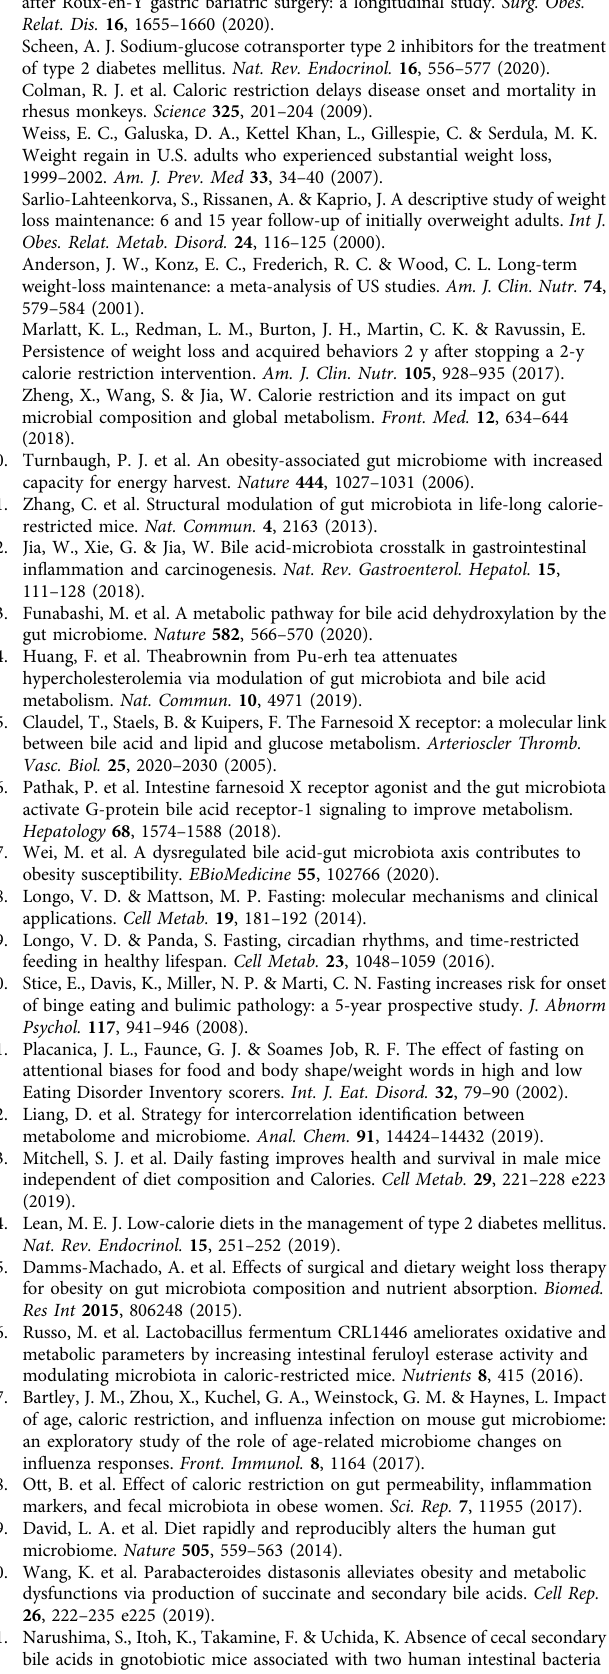
Supplementary Table 2. ChamQ Universal SYBR qPCR Master Mix (Cat: Q711, Vazyme Biotech Co., Ltd., China) was used for quantitative real-time PCR